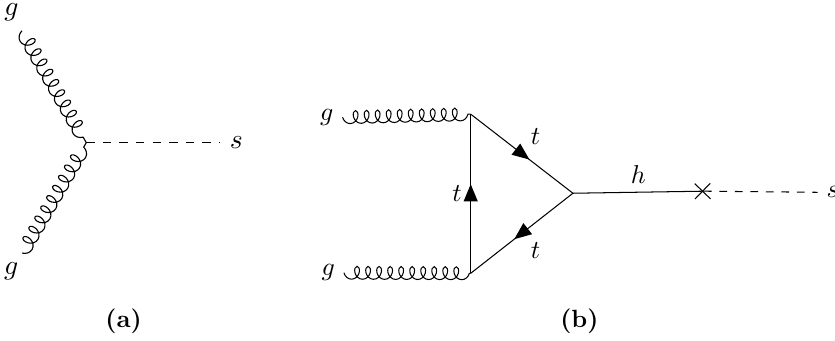
Figure 1. Feynman diagrams for the sgoldstino production via gluon fusion to the leading order in 1 =F ; the cross refers to the Higgs-sgoldstino